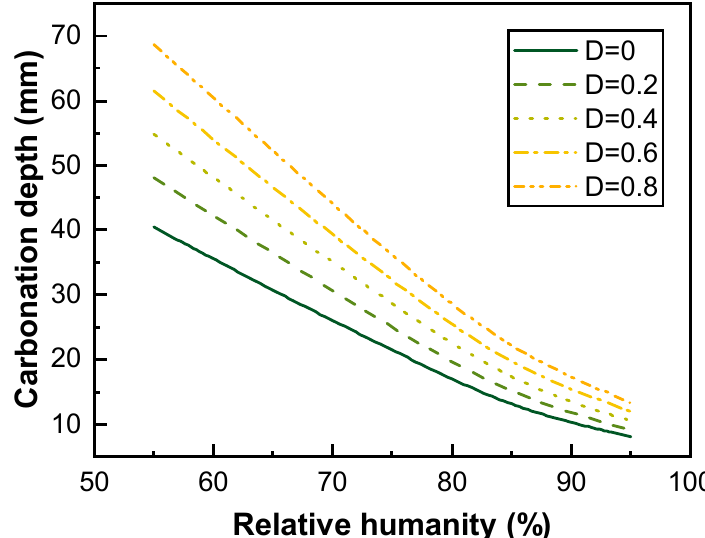
ff ect of relative humidity on the carbonation of fatigue-damaged RC Figure 18. Effect of relative humidity on the carbonation of fatigue-damaged RC beams. Figure 18. E